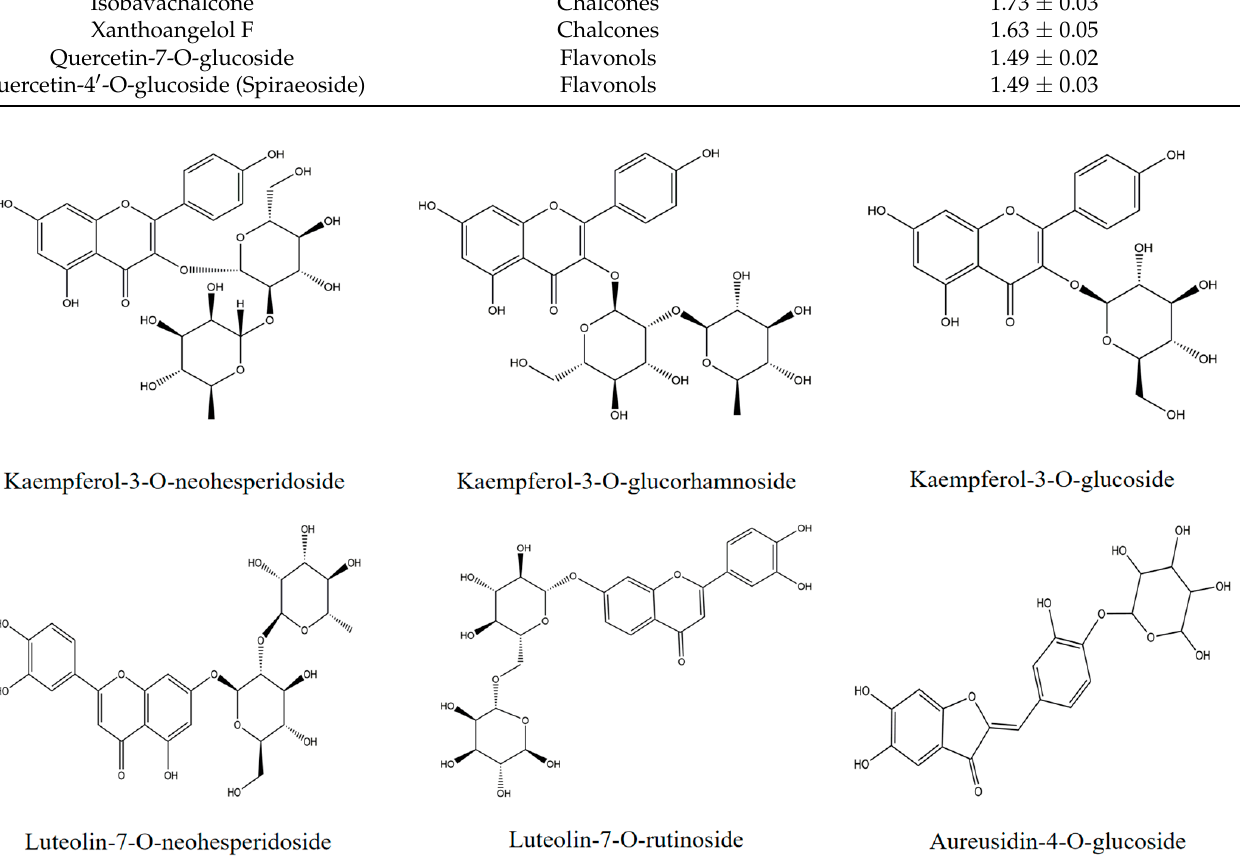
Figure 1. Chemistry structures of the six flavonoids in terms of content in the A. keiskei extrac- tion.